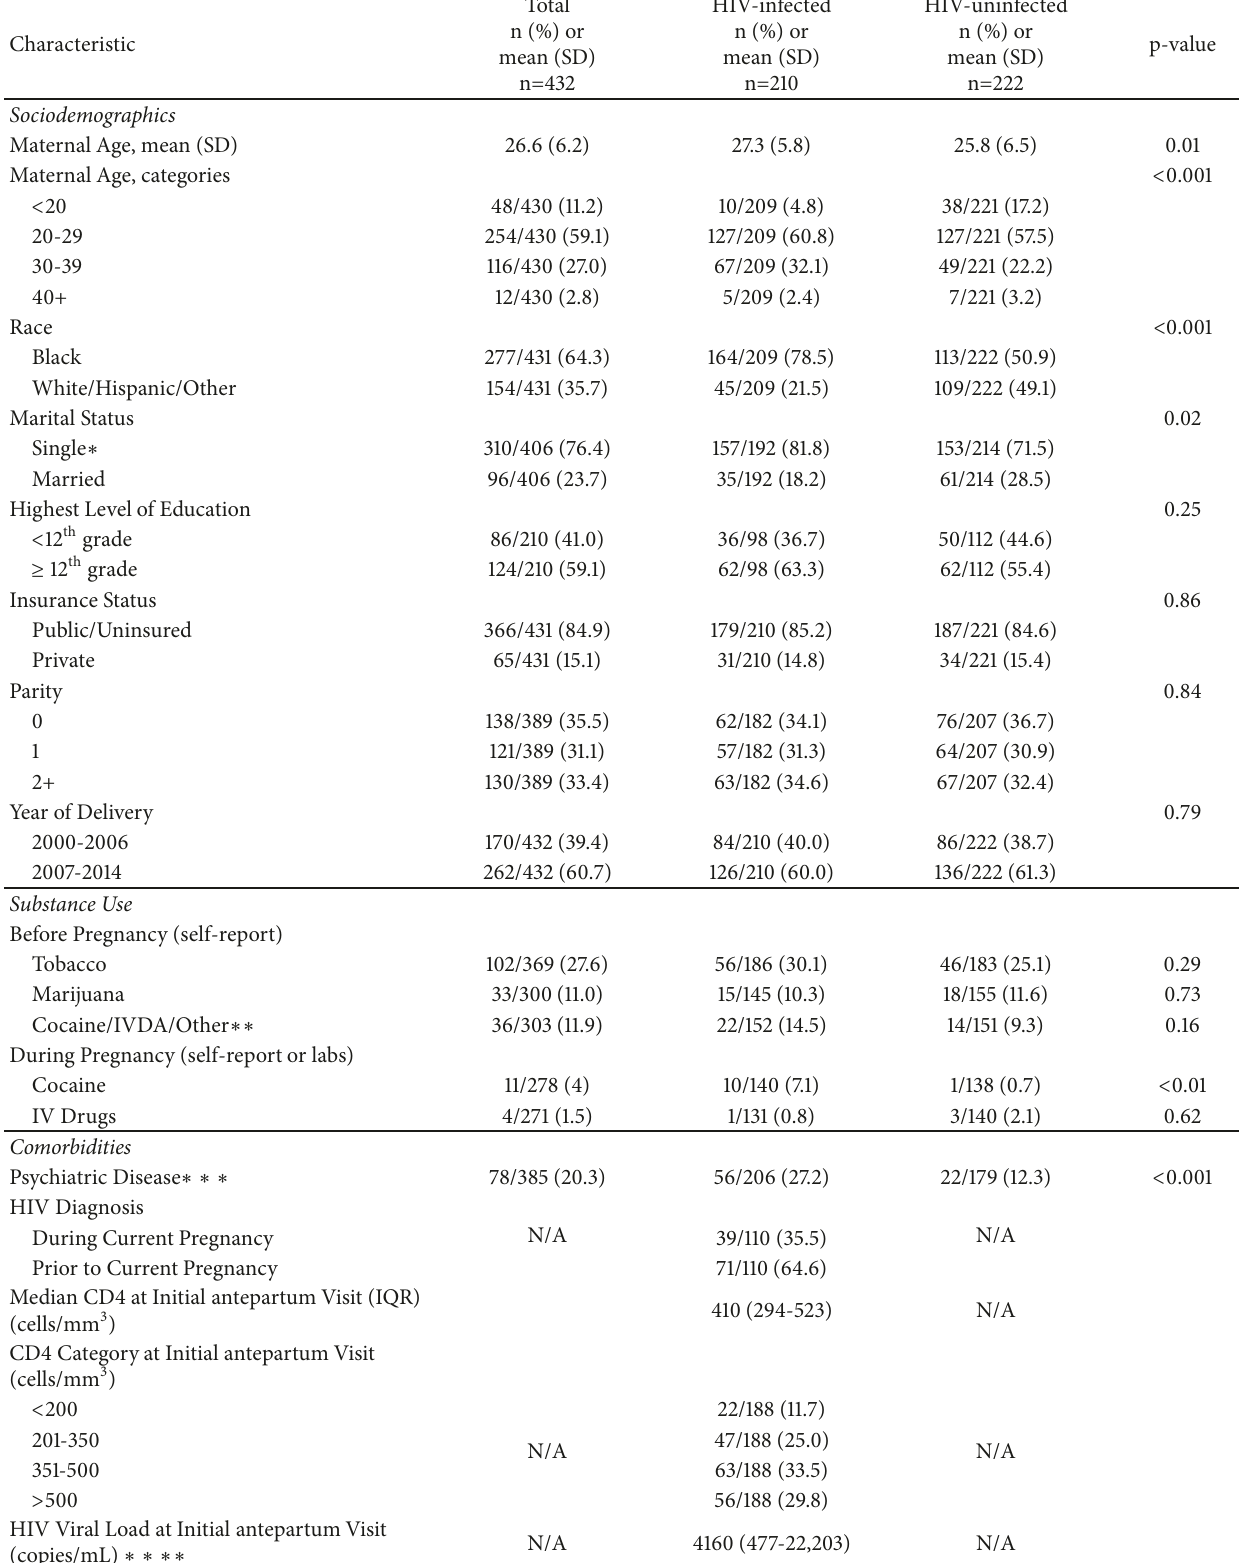
Table 1: Characteristics of pregnant women by HIV status